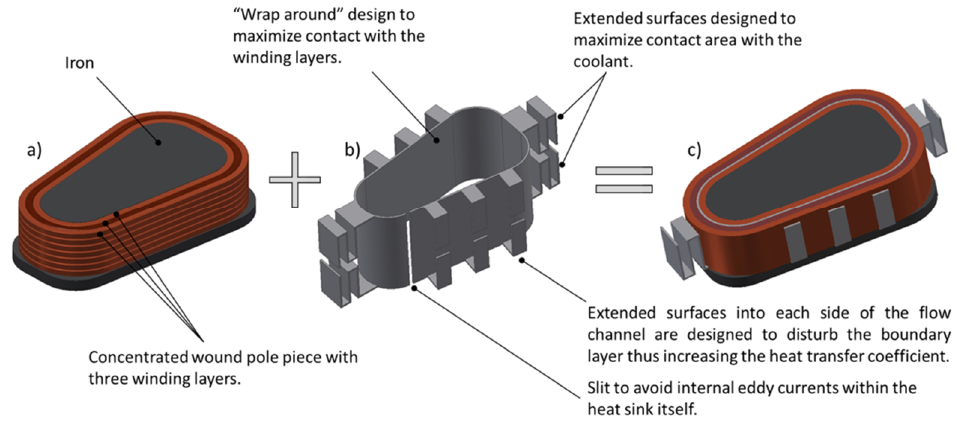
Figure 2. Concept for integrated heat sink: ( a ) Computer-aided design model showing traditional concentrated windings; ( b ) design of heat sink to be integrated in the windings; ( c ) final form the new construction.